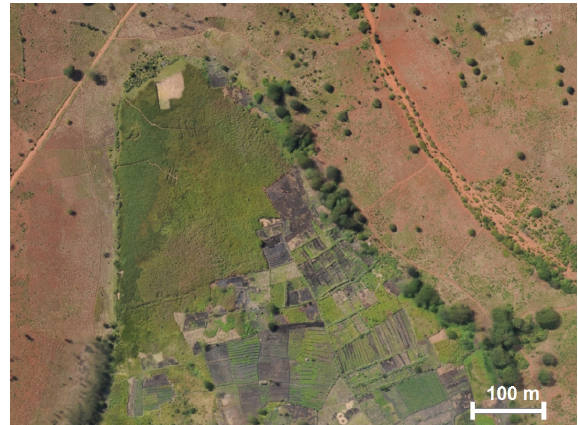
Figure 5. Detail of the ortho-photo from the dry